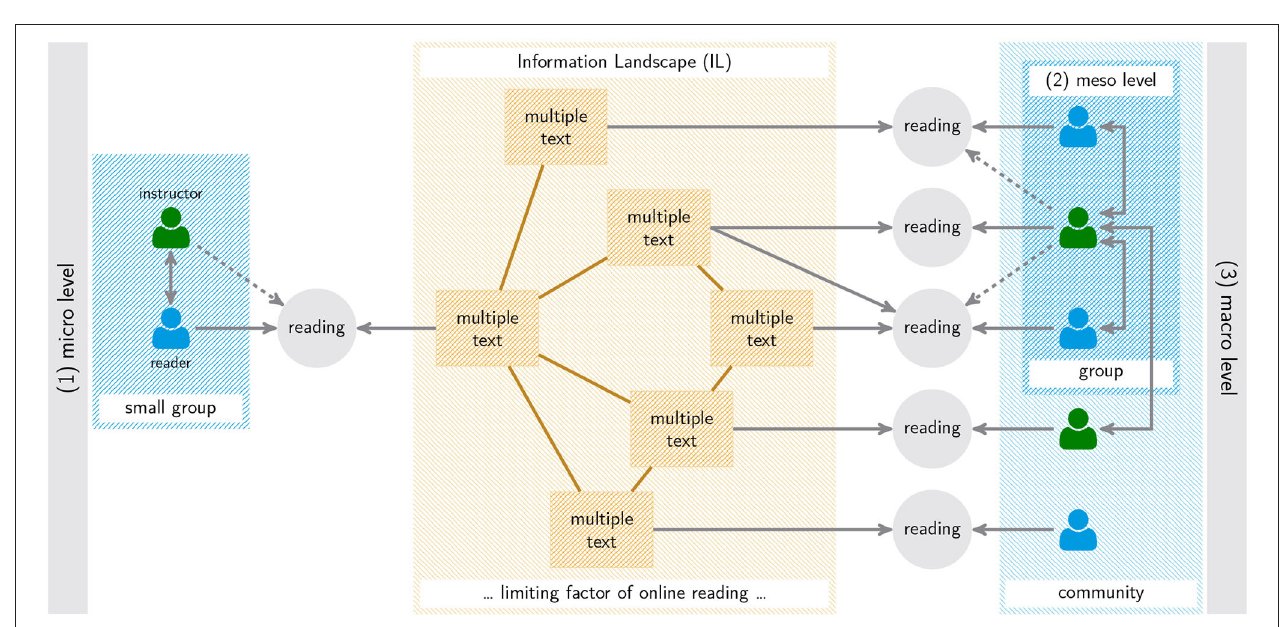
FIGURE 3 | Three research perspectives on multiple texts.